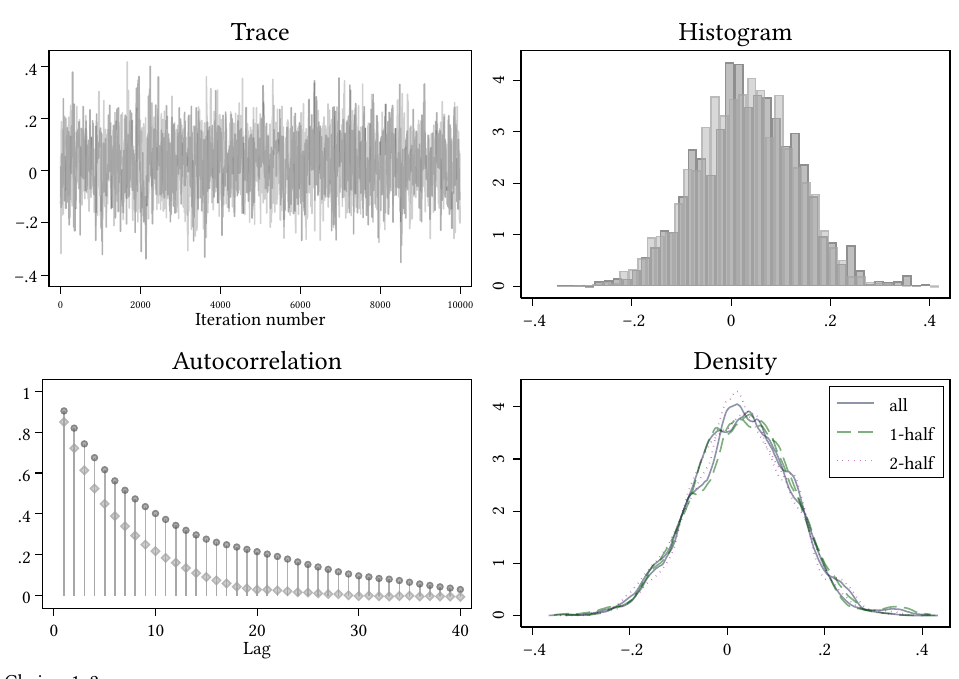
Figure A7. How awareness of the highest asks influences the response to extreme ask. The High Info group.